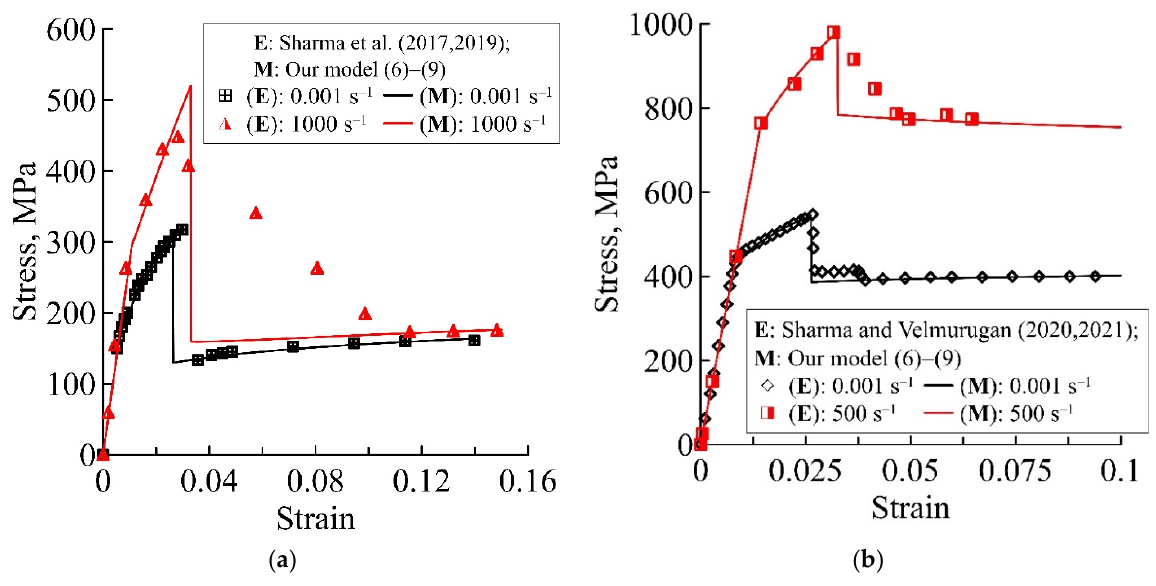
Figure 3. Predicted static and dynamic deformation curves of Me/GFRP/Me laminates using the proposed model (6)–(9), marked by solid lines, with close values for the total thickness ratio of metal and polymer layers: ( a ) 0.48 and ( b ) 0.63. Experimental static and dynamic deformation curves